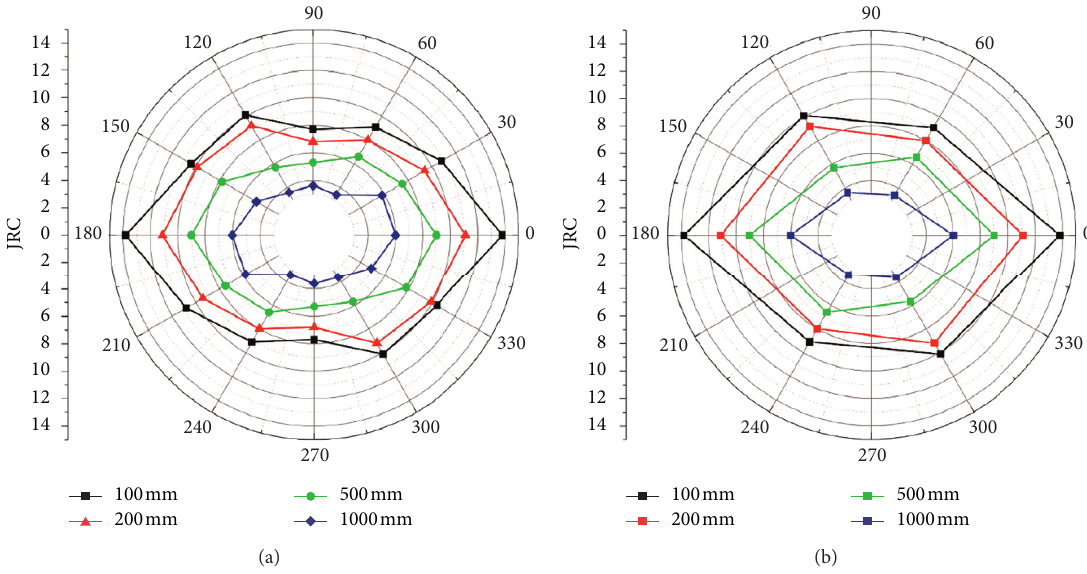
Figure 9: Polar plots of JRC values in the azimuthal intervals of 30 ° and 60 °